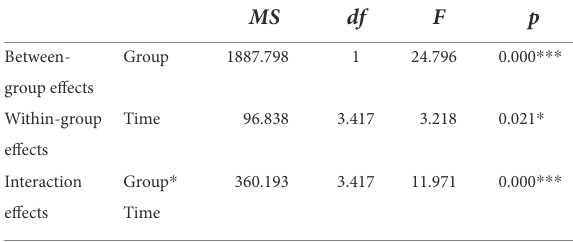
TABLE 9 Repeated measures analysis of variance for sleep